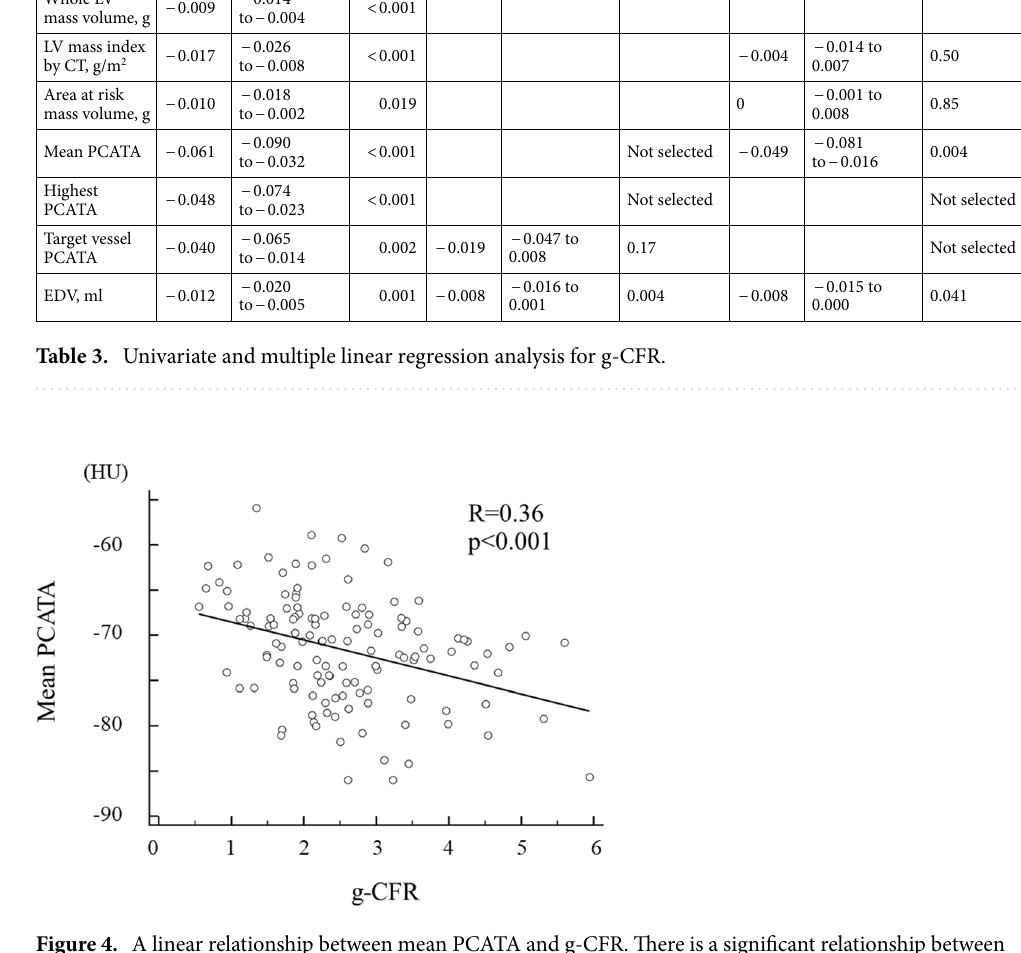
Figure 4. A linear relationship between mean PCATA and g-CFR. There is a significant relationship between mean PCATA and g-CFR (R = 0.37, P <